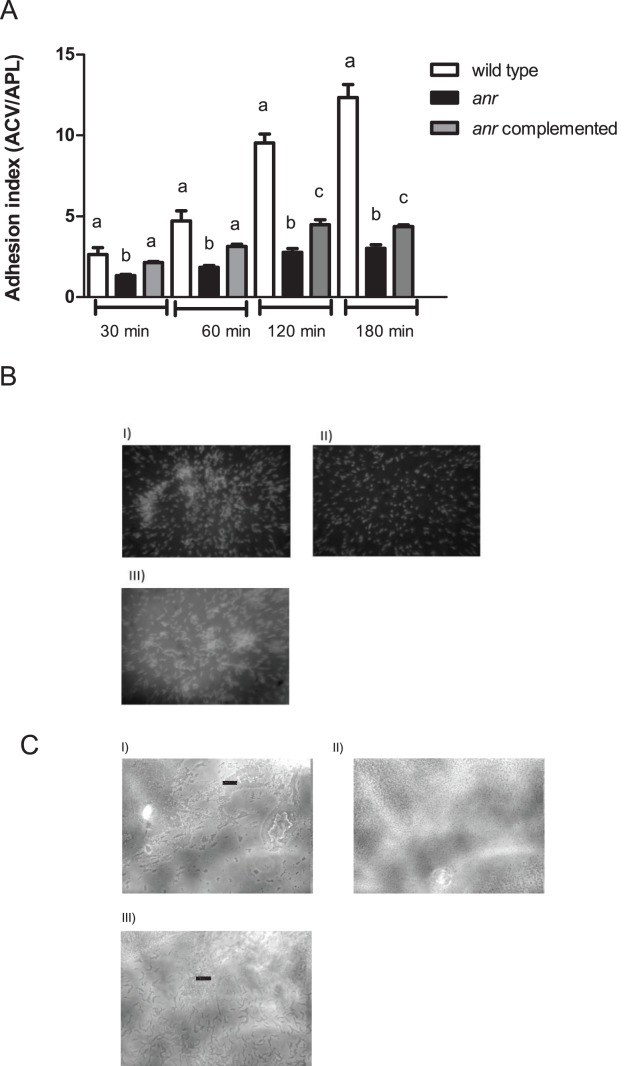
Anr absences decrease attachment and aggregation in P. extremaustralis.(A) Attachment to polystyrene plates in 0.5 NE2 medium supplemented with glucose, KNO3 and casaminoacids. Values represent media ± SD of 5 independent experiments with 12 wells per strain. Different letters showed significant differences among strains (P<0.05) using ANOVA (B). Autoaggregation experiment. The cells were incubated during 2 h without agitation and a culture sample was stained with DAPI. I) wild type strain. II) anr mutant strain. III) anr complemented strain. All observations were performed at 1000X. (C). Slide culture assay to investigate twitching motility. Cells were incubated for 15 h. I) wild type strain. II) anr mutant strain. III) anr complemented strain. Arrows showed rafts in the edge of the culture. All observations were performed using contrast phase microscopy at 400× magnification.